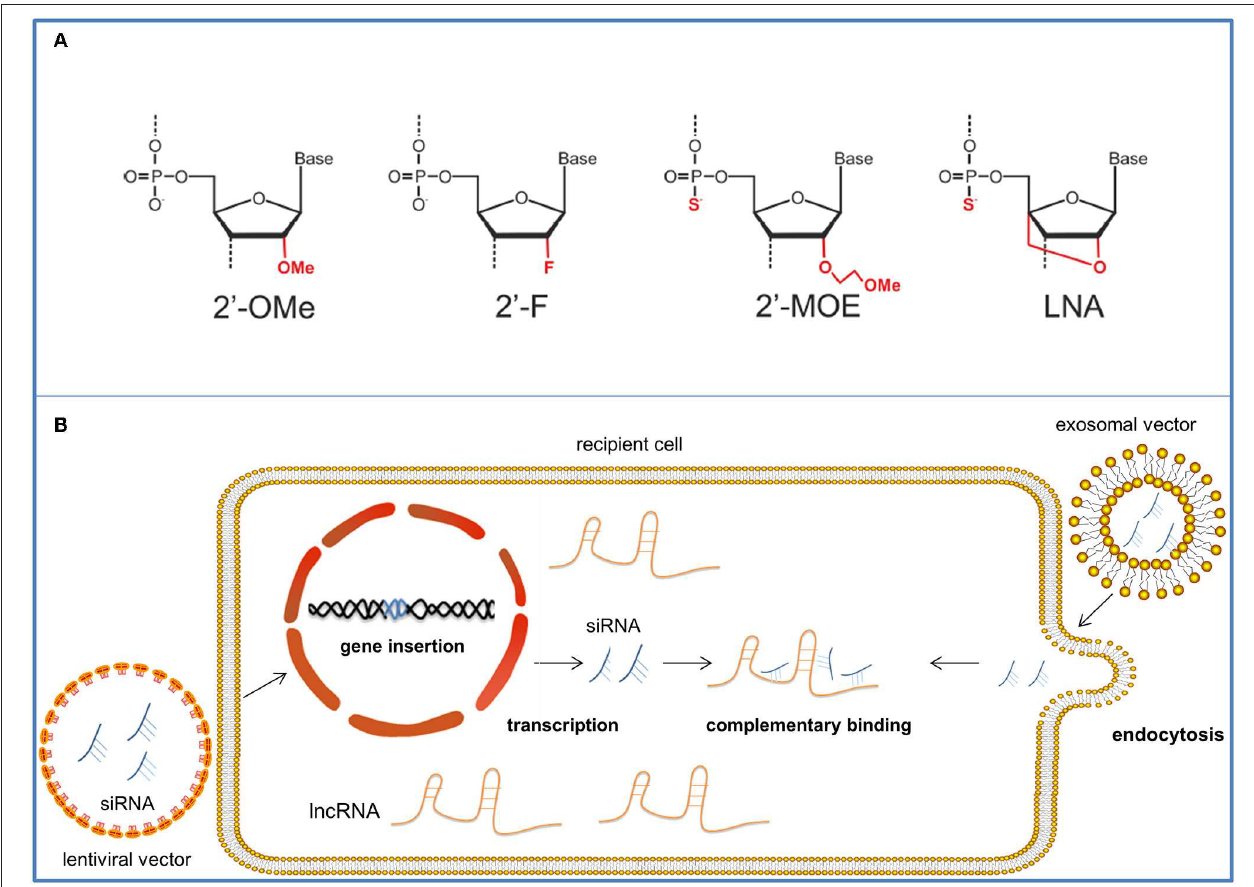
FIGURE 3 | The therapeutic approaches targeting onco-lncRNA—DANCR. The schematic illustrates several targeting methods against onco-lncRNAs by using LNAs or siRNAs for lncRNA silencing and degradation. (A) Antisense oligonucleotides can be chemically modified to have strengthened affinity and stability. The figure shows four common modifications of ASOs. (B) SiRNAs are packaged in nanoparticle vectors for improved targeting. Lentiviral vectors can reverse and insert the siRNA sequence into the genome of target cells and achieve stable transfection. After transcription, siRNAs complementarily bind the target onco-lncRNAs and suppress their tumor promoter functions. Exosomal nanovectors can directly deliver the siRNAs to the target cell cytoplasm for onco-lncRNA inhibition through